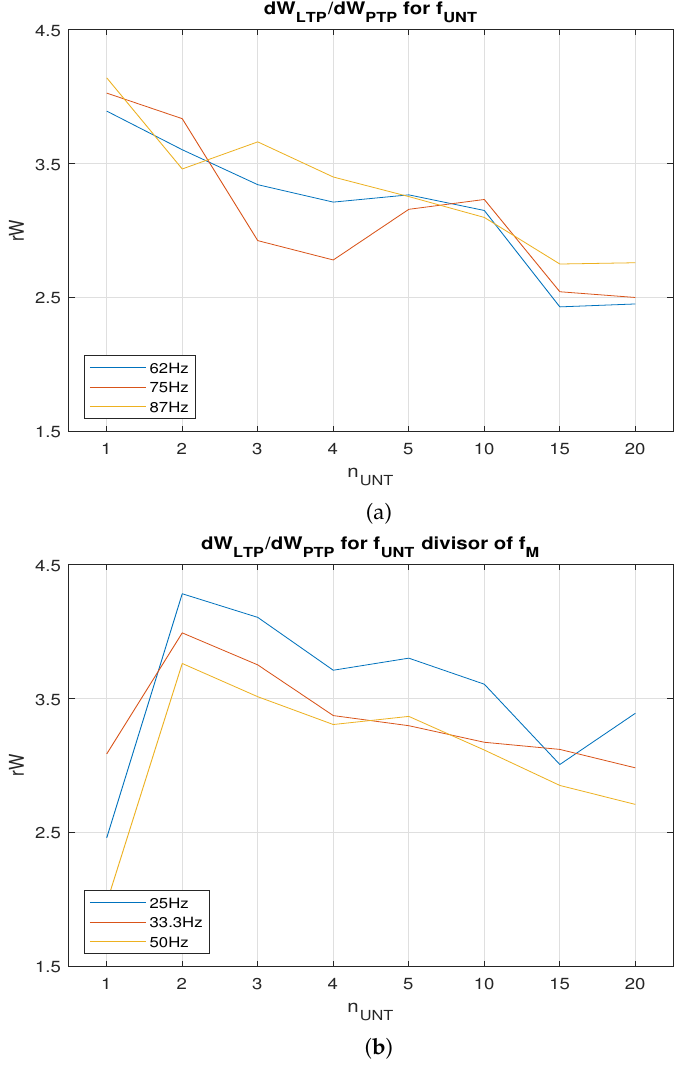
Figure 8. Variation in ratio rW = dW LTP / dW PTP with n UNT when ( a ) f UNT is not a divisor of f M and ( b ) f UNT is a divisor of f M